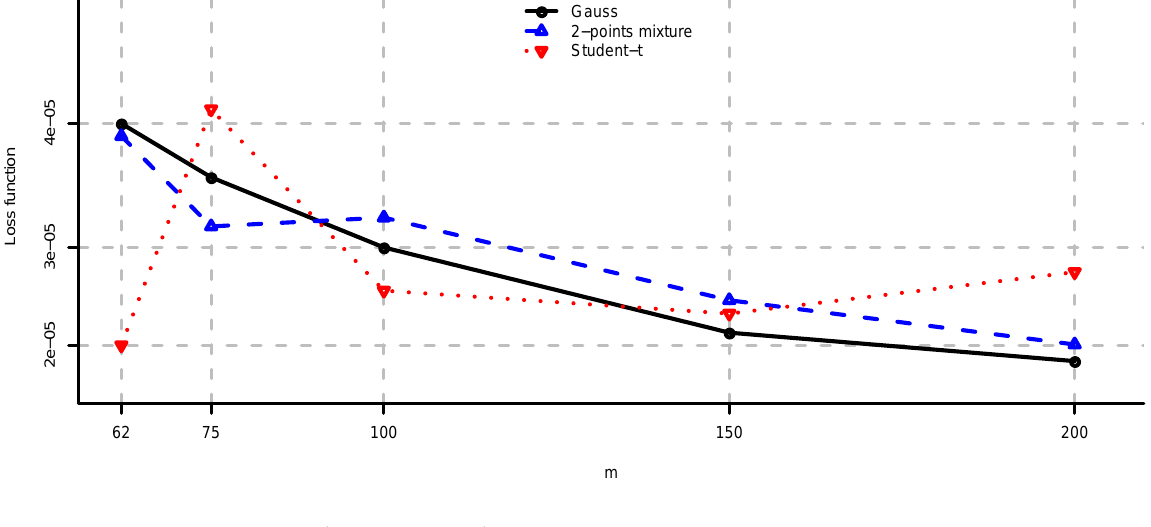
Figure 10. L ( U v , U v , A ) for N = 1000 and different values of m .